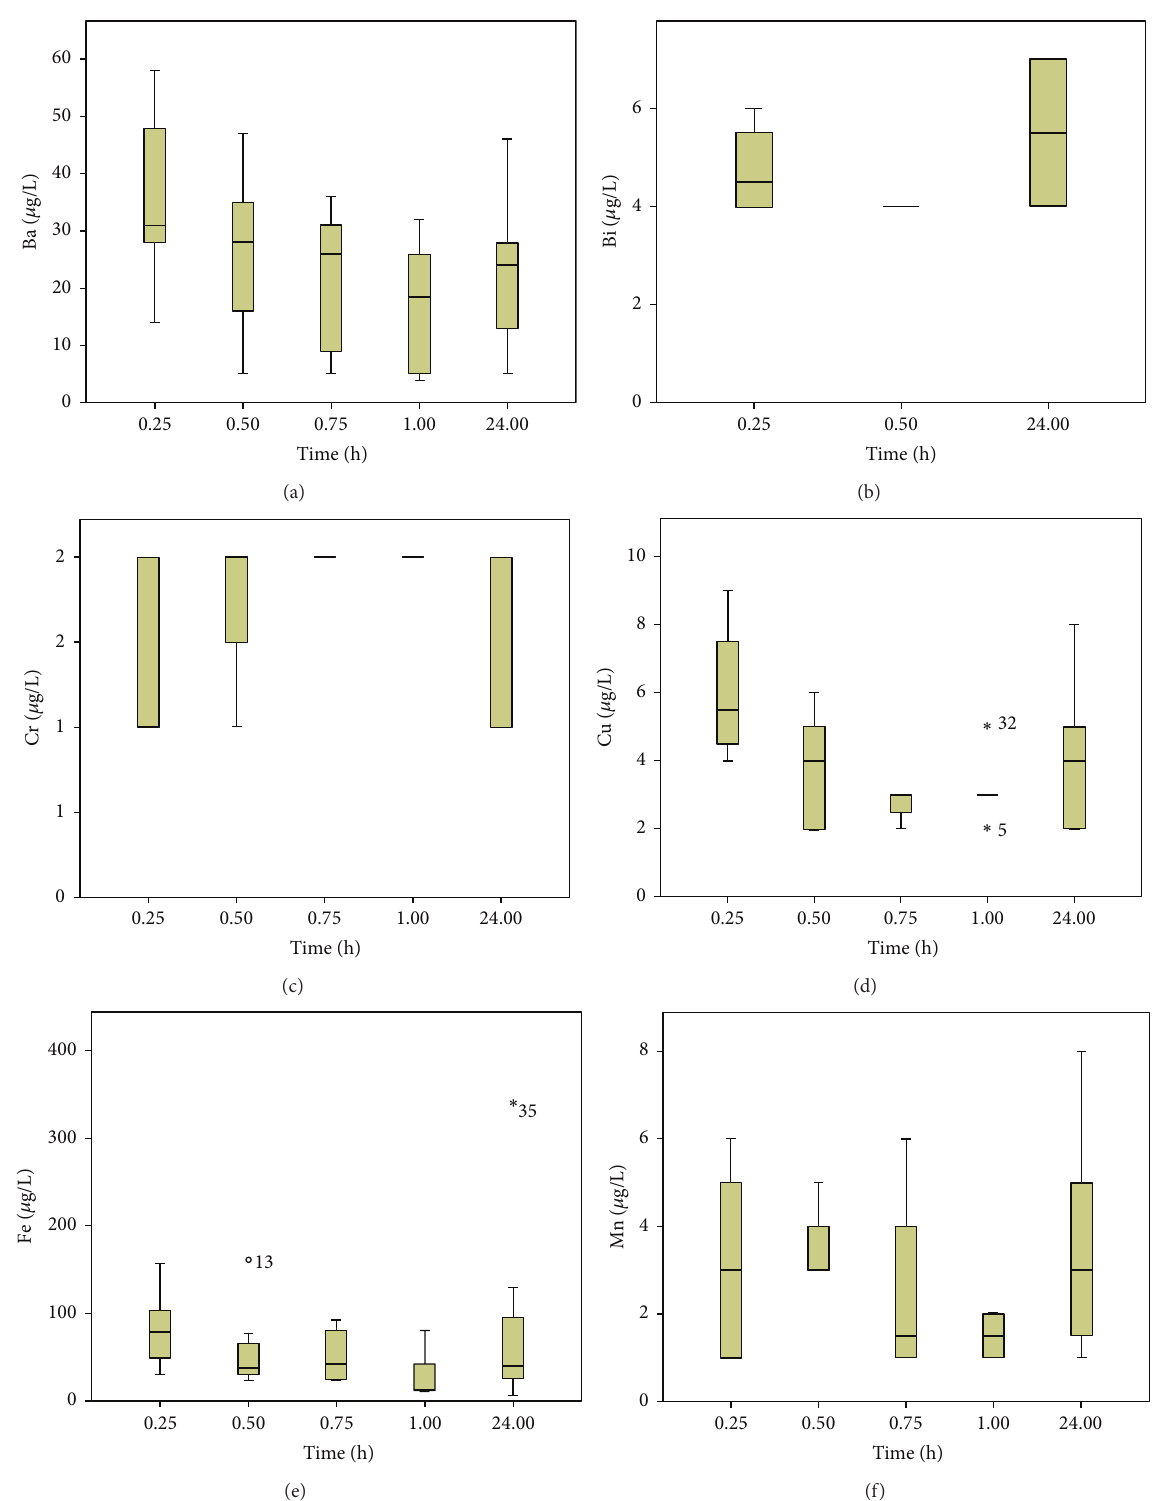
Figure 4: Metals micropollutant (Ba, Bi, Cr, Cu, Fe, and Mn) variations in runoff samples without the first flush sample in Area A (but with the 50 samples per sampling